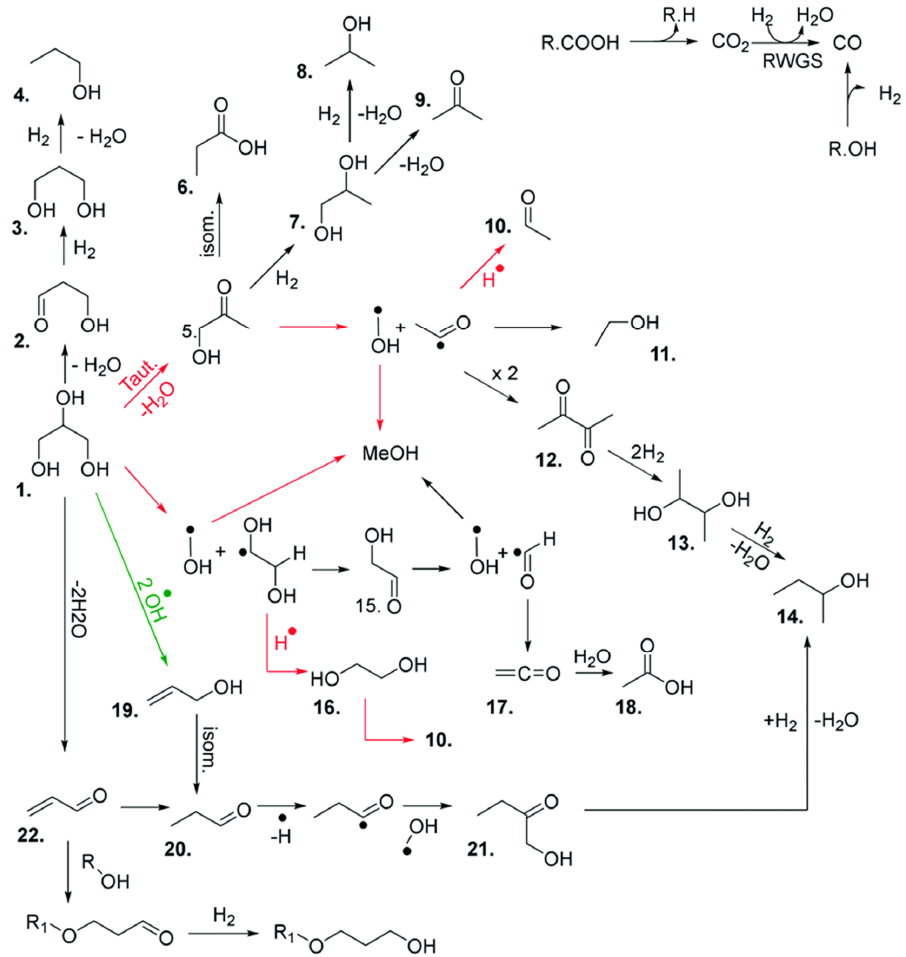
Scheme 2. “Proposed reaction network for the gas phase conversion of glycerol over MgO. Red arrows indicate the dominant pathways over MgO; the green arrow represents the dominant